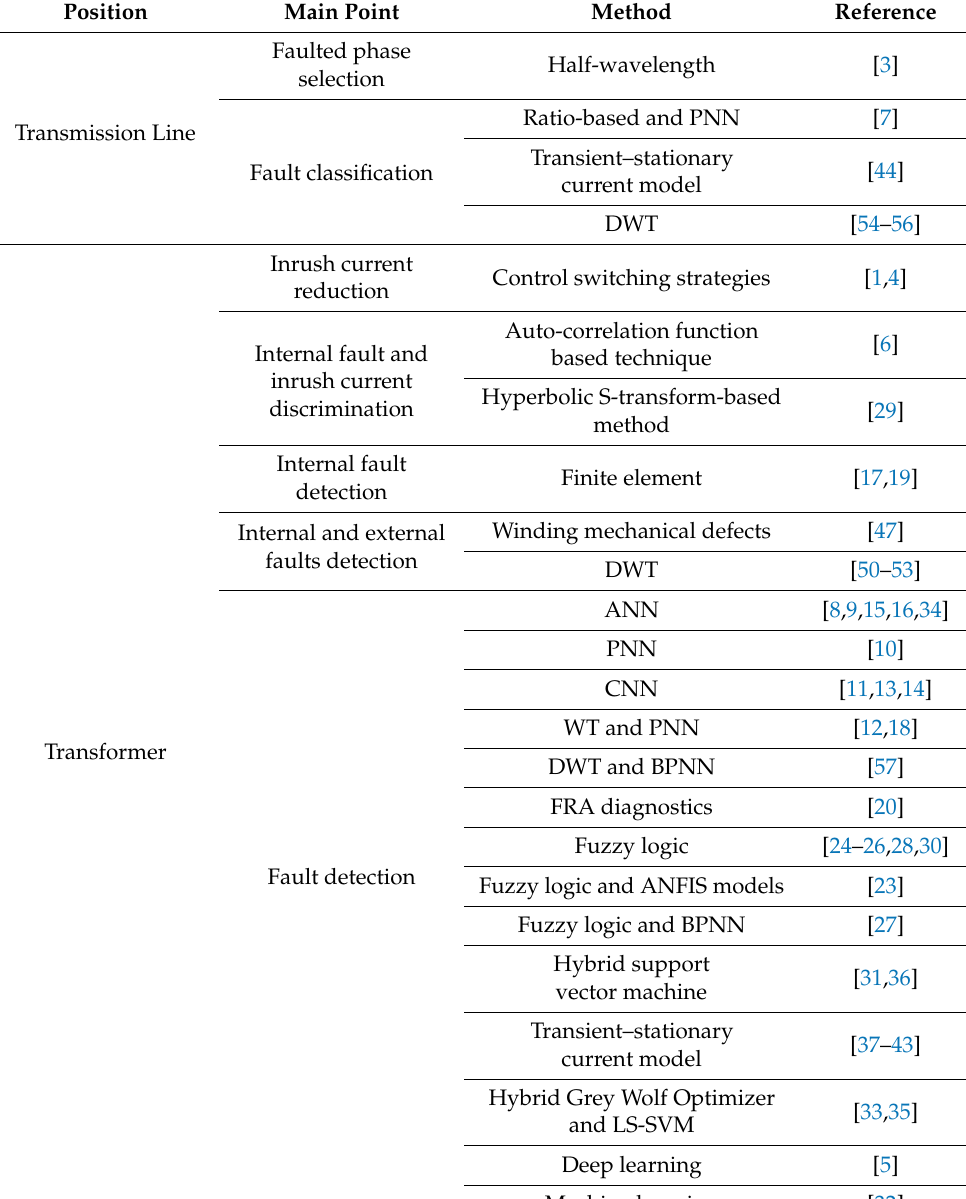
Table 1. A table of literature